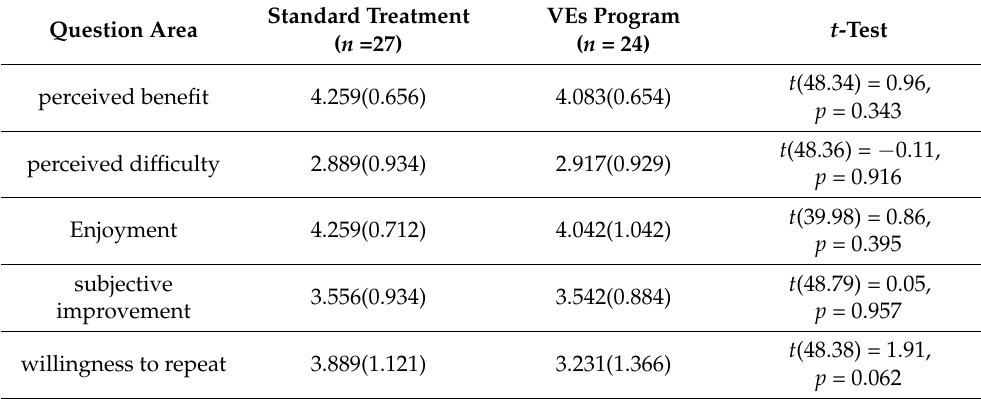
Table 1. Feedback questionnaire results for each treatment and comparison using paired t -test.